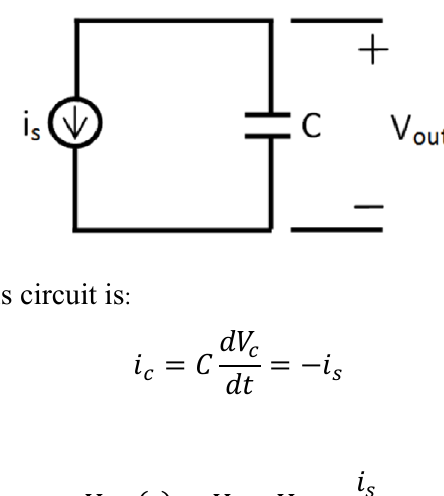
Figure 2. The analogous electrical circuits correspond to the most general first order reaction. ( a ) Analogous electrical model for chemical reaction of element X ( c ) analogous electrical model for chemical reactions of elements of X